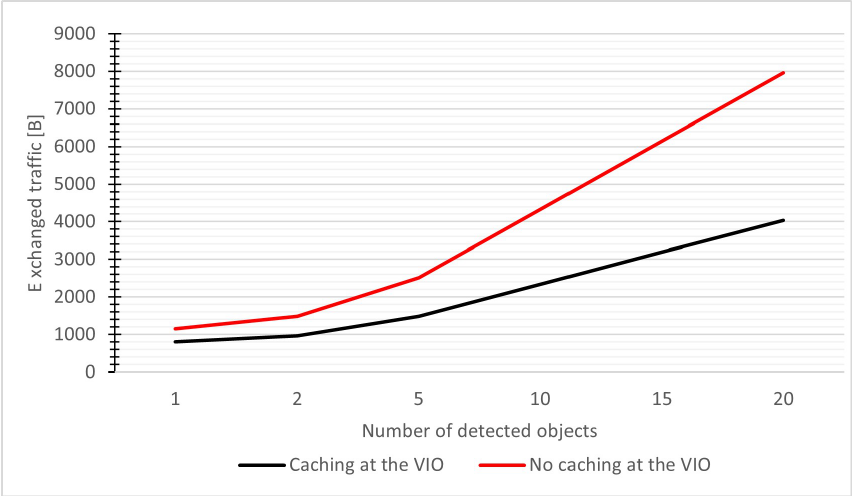
Figure 5. Exchanged traffic when varying the number of detected